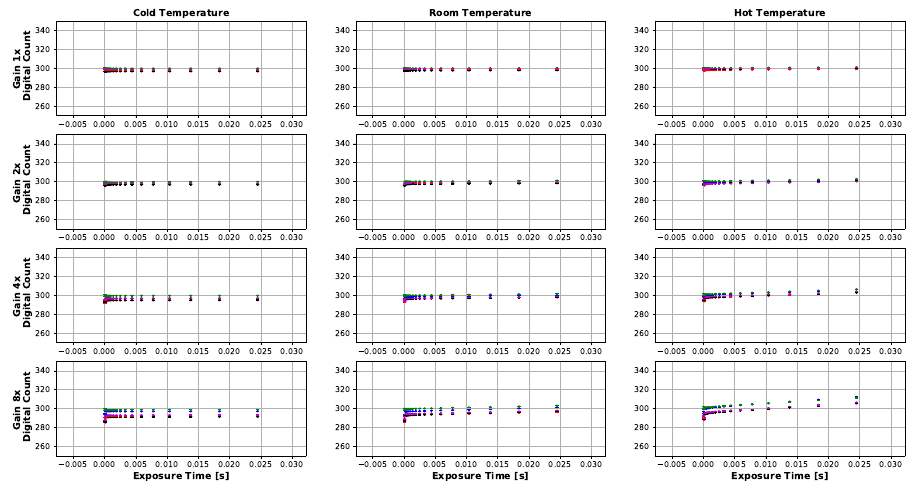
Figure 11. Average dark current (12-bit) produced by MicaSense RedEdge-M sensor at various gains and exposure times. Each dot represents an average of at least 30 images. Bars are one standard deviation. Digital count values hold around 300 except for higher exposure times, gains and temperatures. The highest digital counts values seen were around 320 (24.5 ms, 8 × gain and 37.22 ◦ C). It should also be noted that the digital count values held steady regardless of the increasing temperature throughout the test.